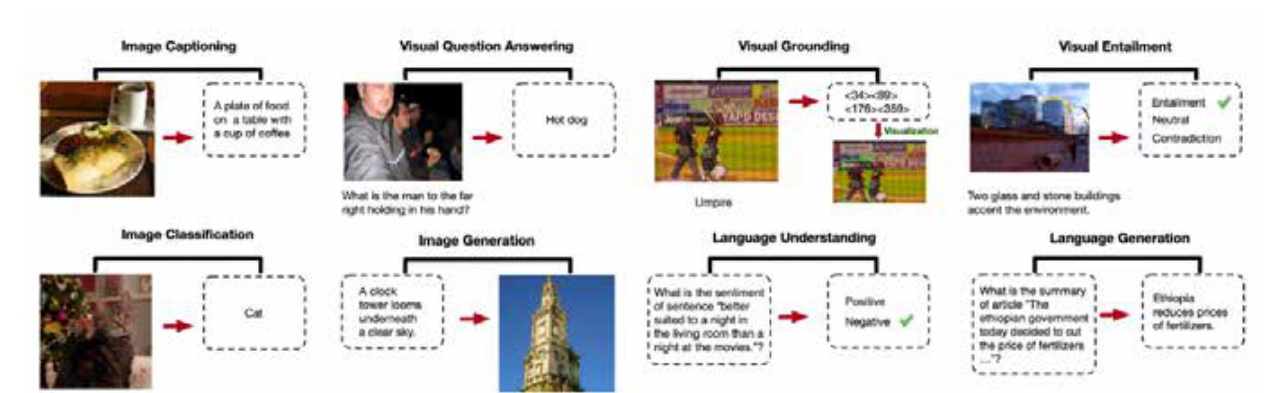
Figure 11 Examples of task domains covered by OFA